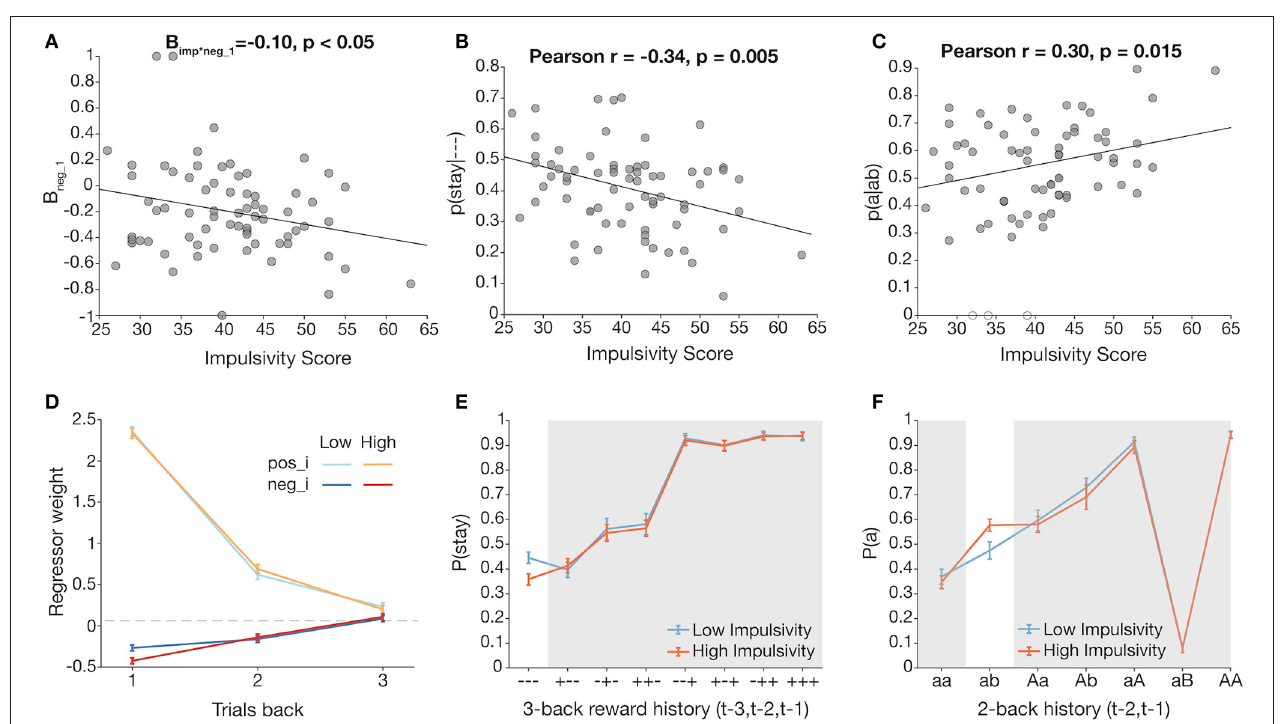
FIGURE 4 | Trial history-dependent analyses reveal effects of impulsivity on staying behavior following unrewarded trials. Pearson correlations were conducted for normally distributed measures. (A) Total impulsivity score vs. normalized neg_1 (negative outcome at t − 1) regressor weights, obtained by fitting a multinomial logistic regression over data by participant. (B) Total impulsivity score is significantly related to p ( stay|- - - ), the probability of staying following three unrewarded trials. (C) Total impulsivity score is significantly related to p ( a|ab ), the probability of returning to a previously unrewarded action following an unrewarded switch. Unfilled data points represent outlier participants. (D–F) Visualizations of impulsivity effects via median split (low impulsivity = blue, high impulsivity = orange). For (D,E) , highlighted columns of plots correspond to the scatterplot directly above. (D) Comparison of neg_i (dark) and pos_i (light) regressor weights (1 ≤ I ≤ 3) with median split for visualization. A negative outcome on t − 1 has a greater effect on switching for the high impulsivity group. (E) Three-back analysis with median split for visualization. (F) aB analysis with median split for visualization.